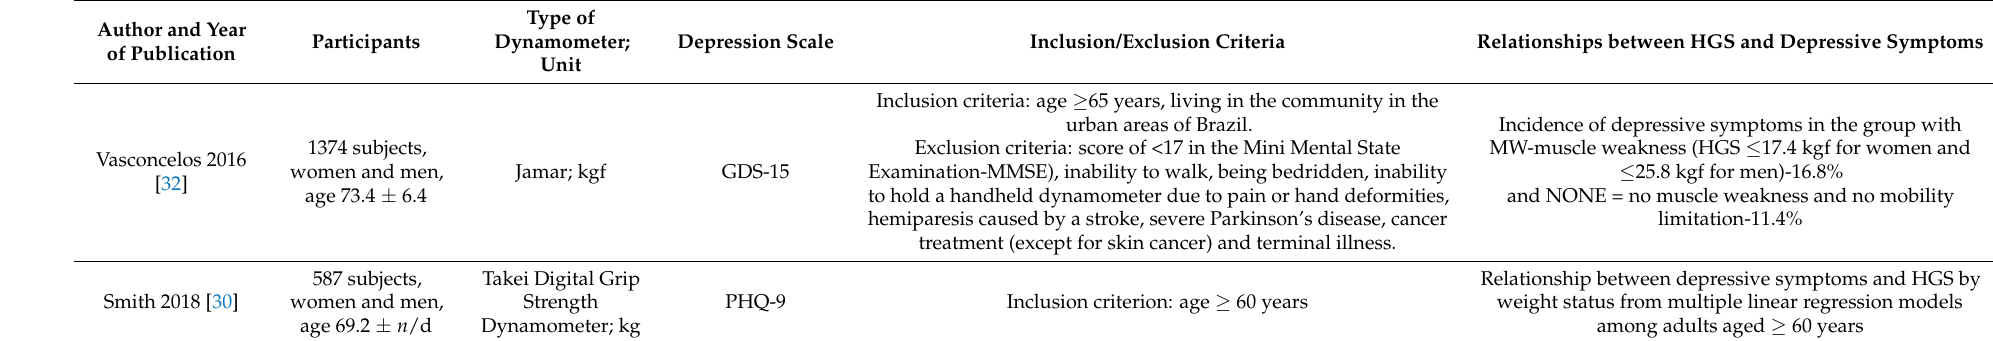
Table 2. Study characteristics and the relationships between handgrip strength and